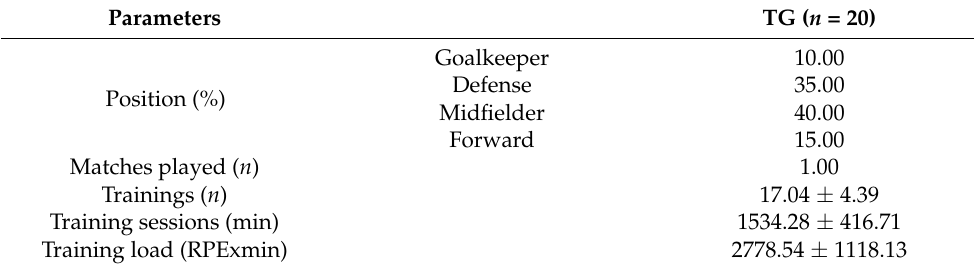
Table 1. Team and training characteristics of soccer players